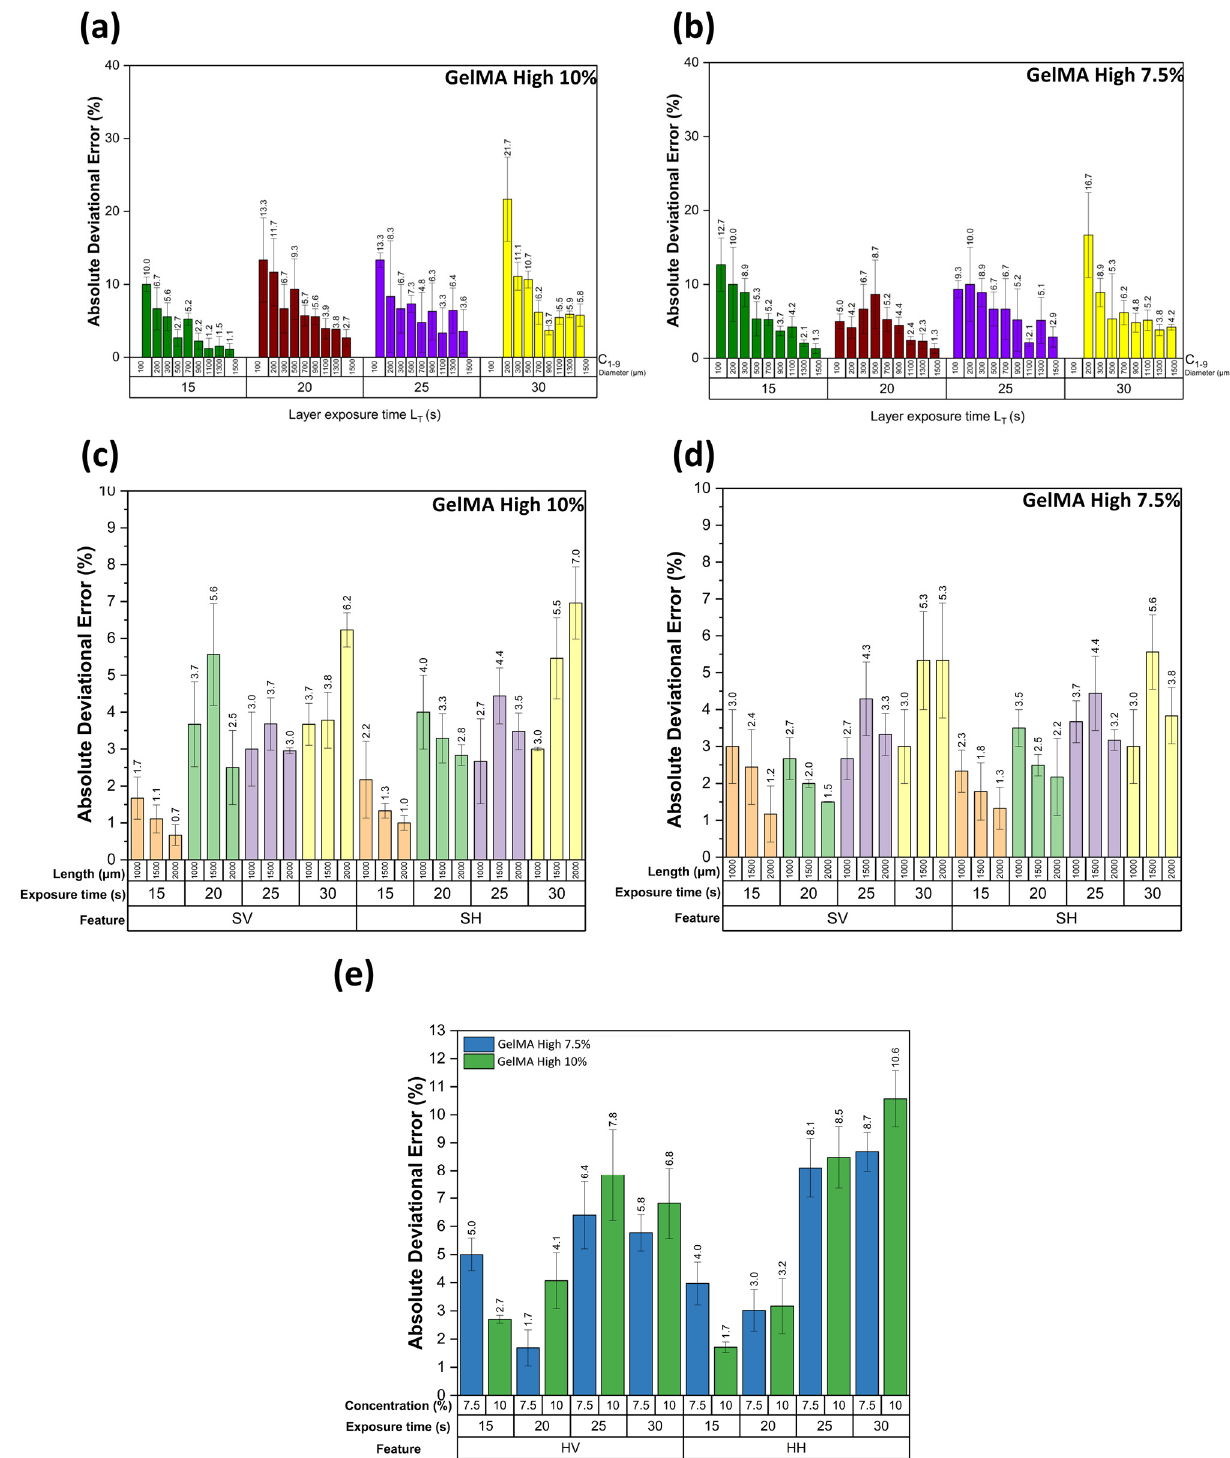
Figure 7. Absolute deviational error graphs of resolution and repeatability assessment figure: ( a ) circular features error at a concentration of 10% GelMA High, ( b ) circular features error at a concentration of 7.5% GelMA High, ( c ) square features error at a concentration of 10% GelMA High, ( d ) square features error at a concentration of 7.5% GelMA High, and ( e ) vertical and horizontal hexagonal features error.